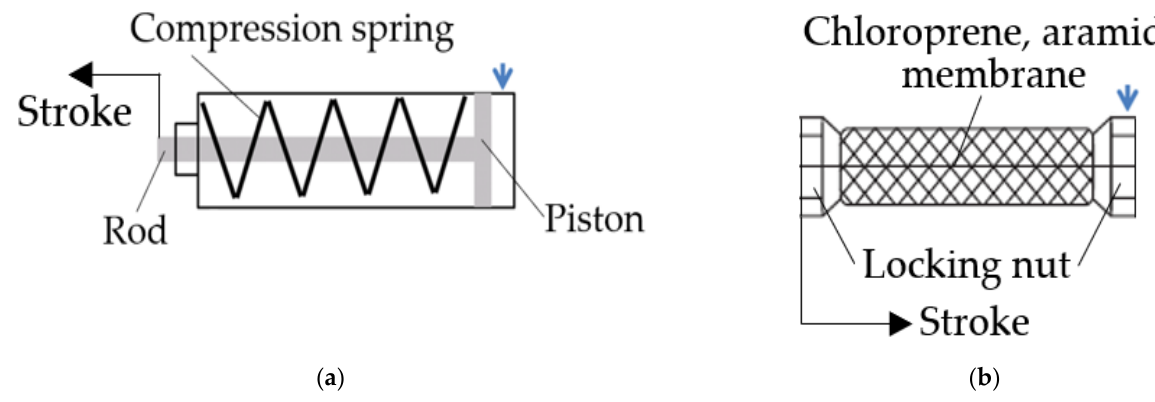
Figure 1. Types of studied pneumatic motors: ( a ) Single-acting cylinder; ( b ) Pneumatic muscle.